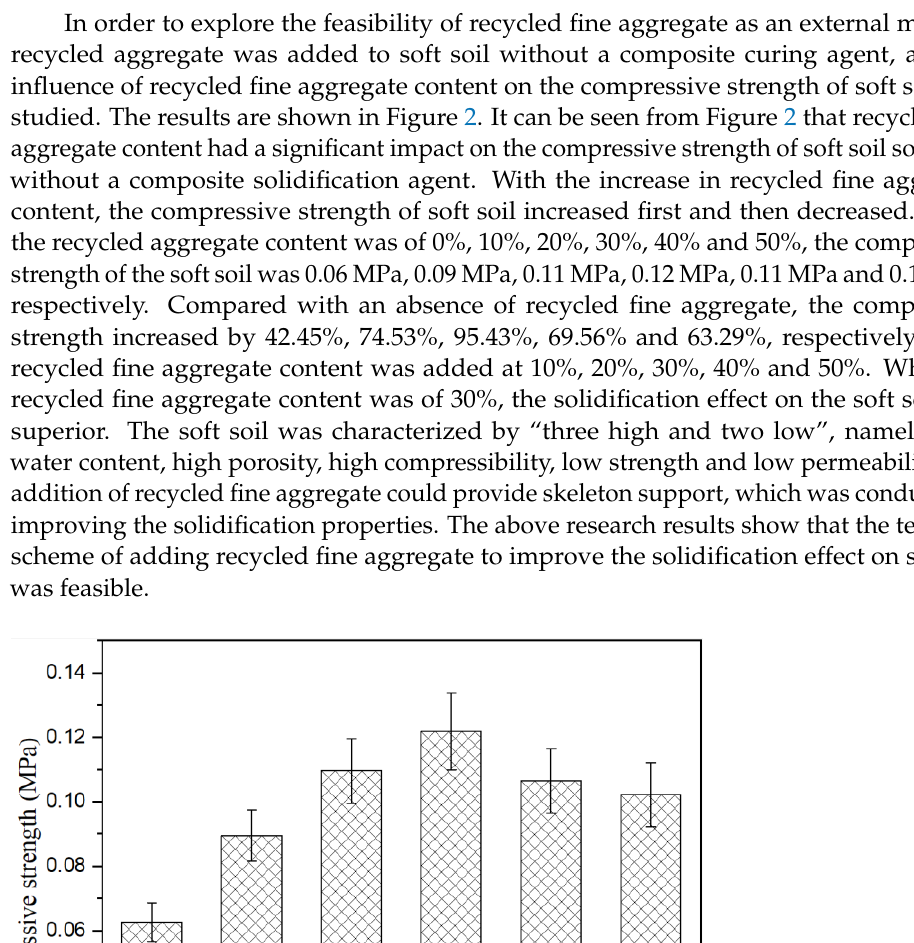
Figure 3. Compressive strength of soft soil solidified by composite solidification agent. 3.2. Composition of Soft Soil Solidified by Recycled Fine Aggregate and Composite Solidification Agent Recycled fine aggregate played a skeleton role in solidified soft soil and, theoretically, it had no significant influence on the composition of the mineral products. This content was systematically and deeply verified by XRD, and the results are shown in Figure 4. MDI JADE 5.0 was used to conduct phase retrieval of XRD spectrogram. Characteristic diffraction peaks of silicon dioxide and aluminum oxide were found under different re- cycled aggregate contents. The diffraction peaks were strong and clean, which represent the main components of soft soil. In addition, a number of new minerals, including hy- drated calcium silicate, calcium hydroxide and ettringite, were produced under different